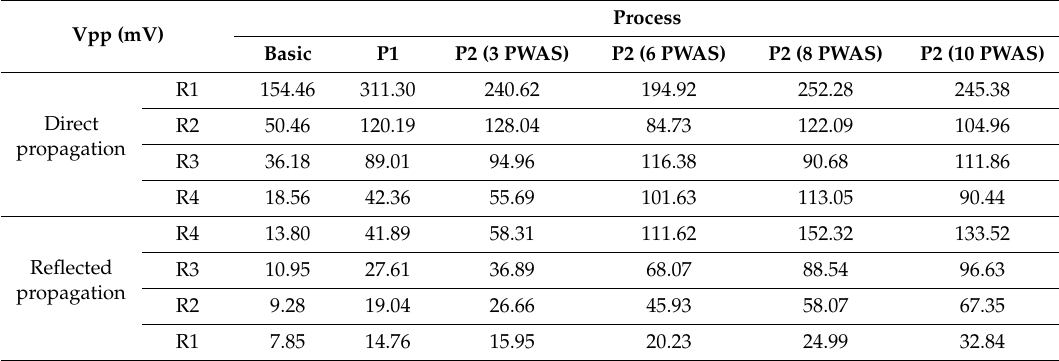
Table 2. Peak-to-peak voltage of the signals acquired in R1 to R4 PWAS along the direct and reflected propagation paths with the di ff erent test procedures.